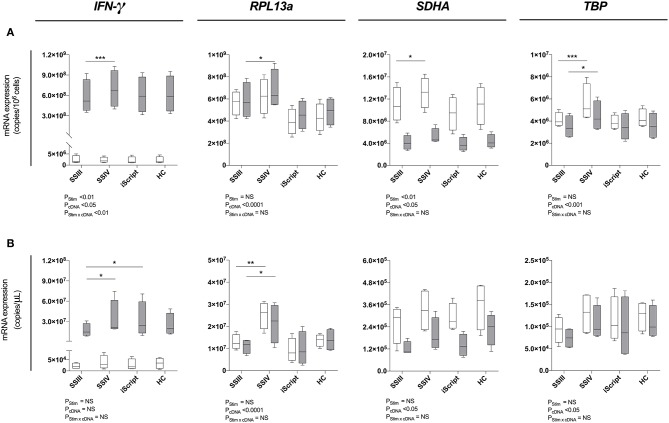
Reverse transcription evaluation. Four reverse transcription kits were evalued for relative qPCR signal for (A) maximal RNA yield, or (B) maximal RNA concentration. When maximizing RNA yield, RNA was extracted with MagMAX™ mirVana™ (MagMAX) Total RNA Isolation Kit (Applied Biosystems); when maximizing concentration, RNA was concentrated with RNeasy® MiniElute Cleanup Kit (QIAGEN). RNA was reverse transcribed with either Superscript™ III (SSIII), Superscript™ IV (SSIV) (both Invitrogen), iScript™ Advanced (iScript) (BioRad) or High-Capacity (HC) (ThermoFisher) reverse transcription kits. RNA was extracted from 1 × 106 PBMCs pared samples, cultured with complete media (white) or PMA/Iono (gray) for 6 h, then IFN-γ, RPL13a, SDHA, and TBP mRNA expression was quantified. Data were compared with a two-way ANOVA (*P ≤ 0.05; **P ≤ 0.01; ***P ≤ 0.001 for post-hoc Bonferroni's multiple-comparisons test). Biological replicate (n = 4), single RNA extractions, with triplicate reverse transcription reactions per extraction were performed. Sample mean calculated from the mean of the reverse transcription reactions calculated from the mean of the technical triplicate qPCR reactions. Biological mean ± biological SEM are shown.